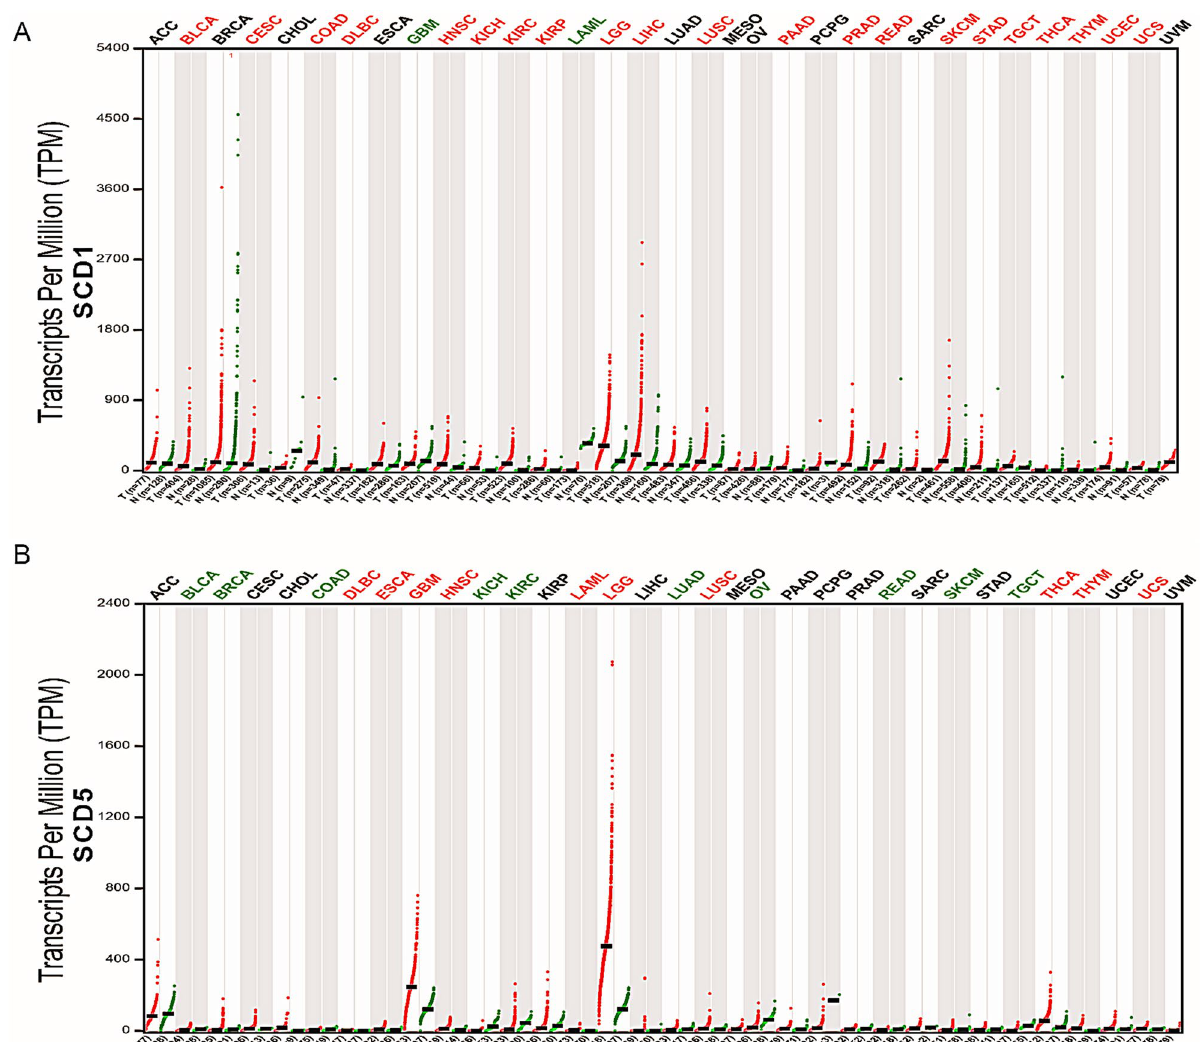
Figure 1. The mRNA expression of SCD1 and SCD5 in human cancers. ( A ) The mRNA expression of SCD1 between tumor and normal tissue was assessed using tissues from TCGA and GTEx. ( B ) The mRNA expression of SCD5 between tumor and normal tissue was assessed using tissues from TCGA and GTEx. Cancer types in red font indicate that SCD1 or 5 mRNA expression was upregulated in tumors compared to their normal counterparts. Cancer types in green font indicate that SCD1 or 5 mRNA expression was down-regulated in cancers compared to their normal counterparts. T tumor, N